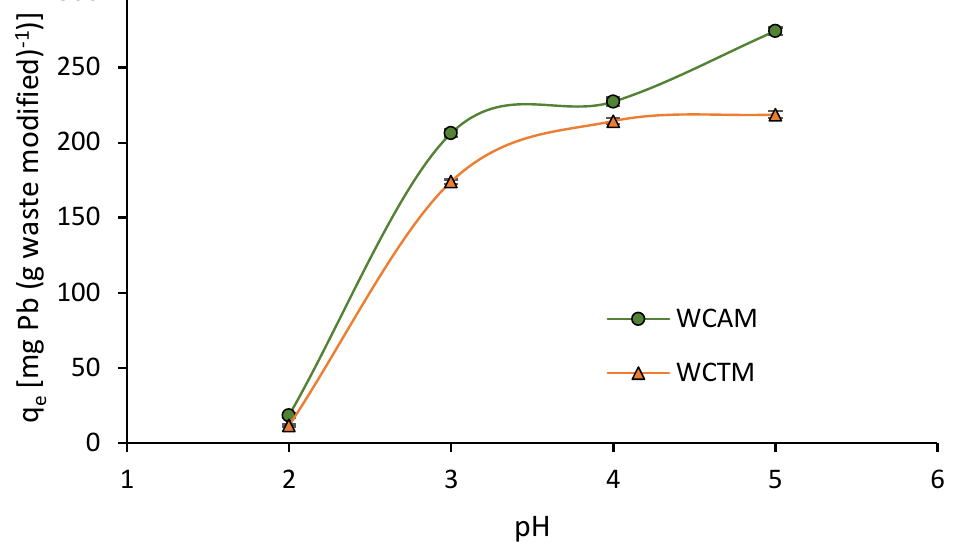
Figure 5. Influence of pH on the Pb(II) adsorption capacity, q e , for T = 293 K, adsorption time = 120 min, biosorbent dose = 2 g L − 1 , C 0 = 130.8 mg L − 1 .